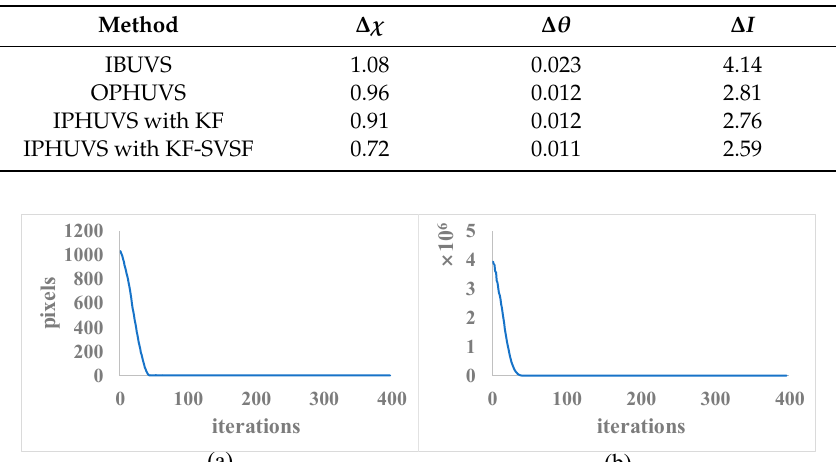
Table 5. Steady-state error of di ff erent strategies in the static positioning experiment. ∆ χ is in millimeters, ∆ θ is in degrees and ∆ I is in pixels.